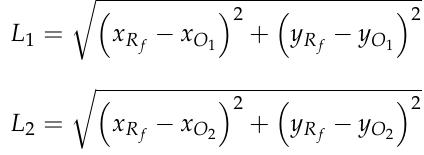
Figure 5. Transfer arbiter. ( a ) shows the distribution of candidate targets for the current scene; ( b ) is the result of histogram statistics of the distance between candidate frames; ( c ) shows the track ‐ ing results and the center distance of similar objects schematically.